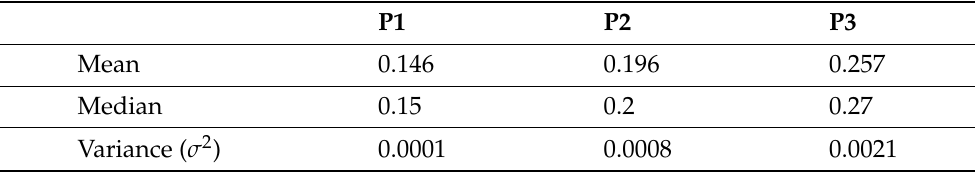
Table 4. Statistical results for increased cost ratio of P1, P2, and